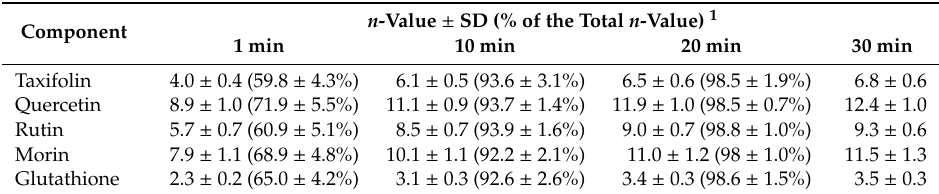
Table 1. The n -values for flavonoids and glutathione at di ff erent incubation times. All n -values were statistically di ff erent ( p <